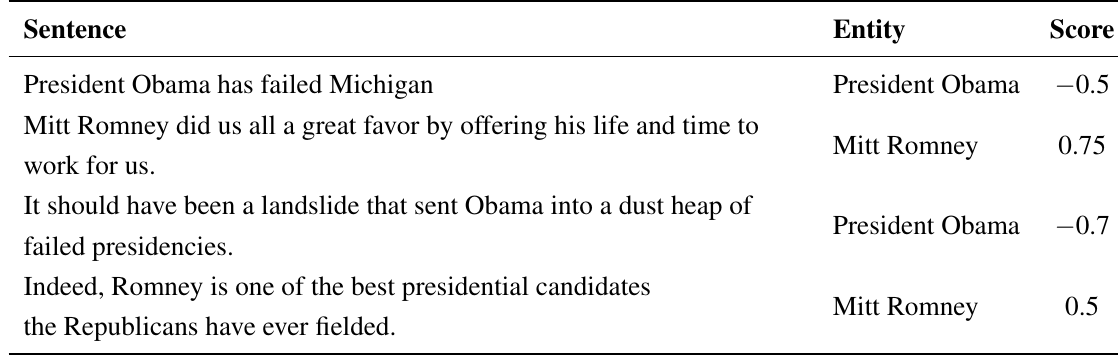
Table 1. Examples of opinionated